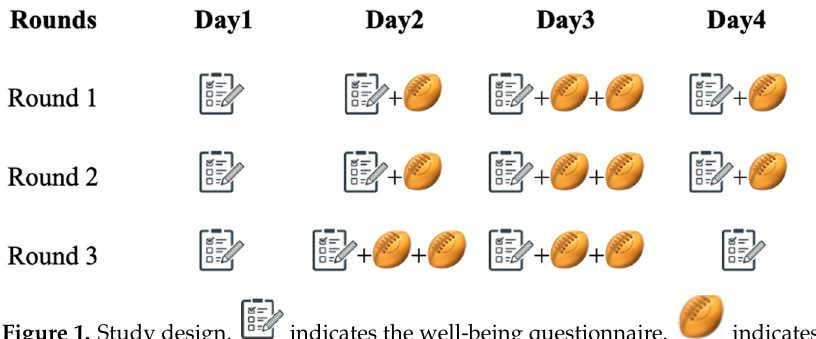
Figure 1. Study design. indicates the well ‐ being questionnaire. indicates the investigated matches across the three rounds.